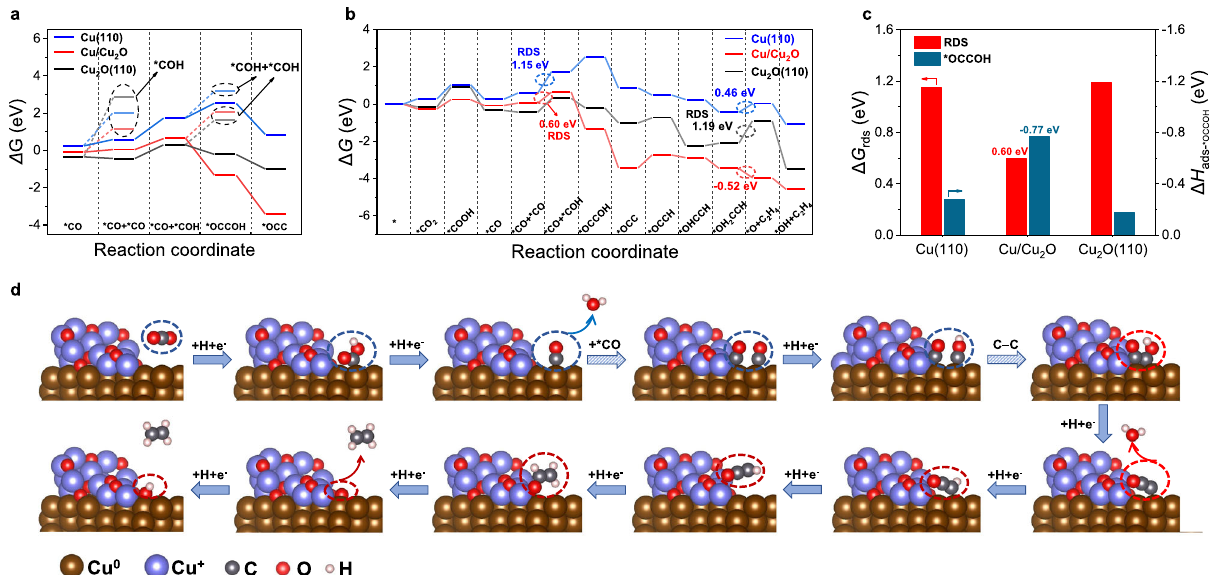
Fig. 7 DFT calculation results. a A reaction energy diagram for the CO 2 RR to *COH (the intermediate of CH 4 formation) and to *OCC through different dimerization pathways on the Cu(110) slab, Cu/Cu 2 O interface and Cu 2 O(110) slab. b A reaction energy diagram for the CO 2 RR to C 2 H 4 on the Cu(110) slab, Cu/Cu 2 O interface and Cu 2 O(110) slab. c The free energy of the rate-determined step for the CO 2 RR to C 2 H 4 pathway and the adsorption energy of the *OCCOH intermediate on the Cu(110) slab, Cu/Cu 2 O interface and Cu 2 O(110) slab. d Optimized structures for the reaction intermediates of the C 2 H 4 formation pathway on the Cu/Cu 2 O